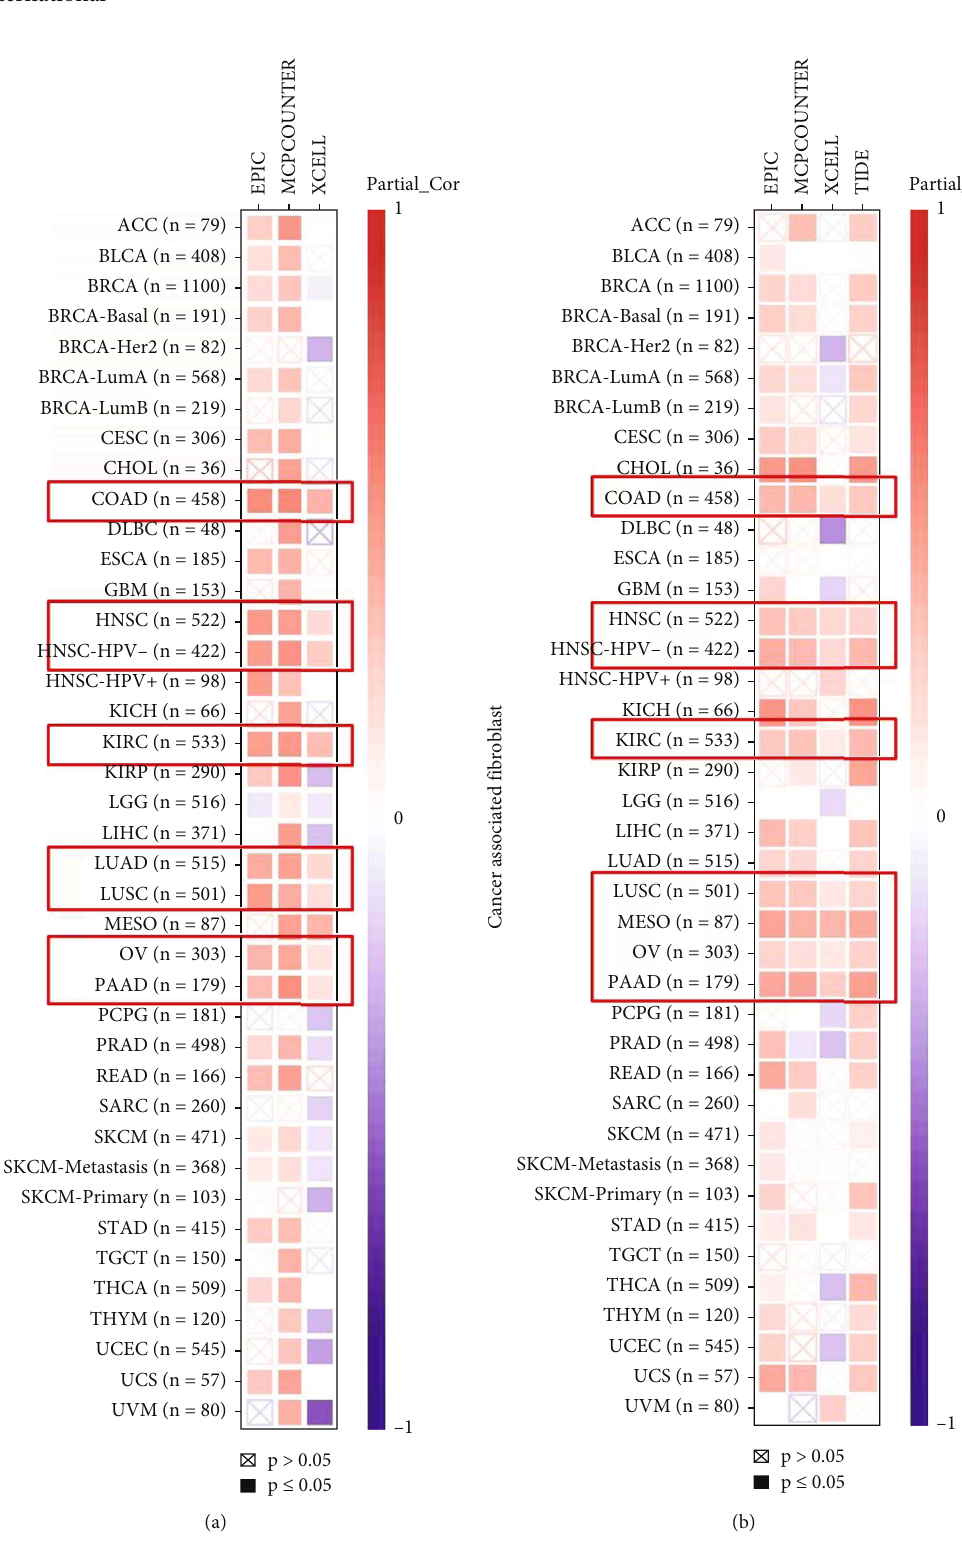
Figure 5: The relation among PBRM1 expressive level and invasion of endothelial cells and cancer-related fi broblasts. (a) TIMER, CIBERSORT, CIBERSORT-ABS, TIDE, XCELL, MCPCOUNTER, QUANTISEQ, and EPIC algorithms were used to analyze the correlation between endothelial cell level and PBRM1 gene expression level of all tumors in TCGA. (b) TIMER, CIBERSORT, CIBERSORT-ABS, TIDE, XCELL, MCPCOUNTER, QUANTISEQ, and EPIC algorithms were utilized to analyze cancer-related fi broblast invasion levels and PBRM1 gene expressive levels in all tumors in TCGA. Red represents a positive correlation (0 – 1), while blue indicates an opposite correlation ( − 1 – 0). The relation with P < 0 : 05 was statistically signi fi cant. Statistically insigni fi cant correlation values are signed with a